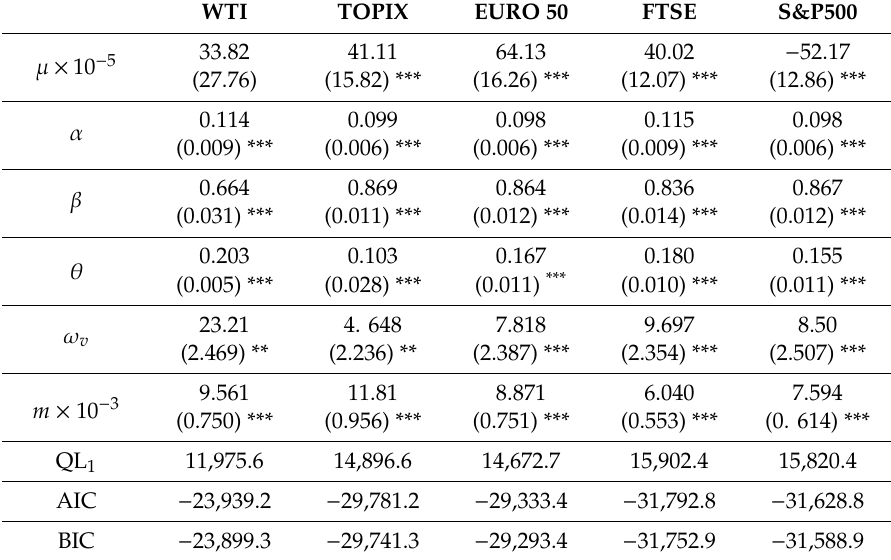
Table 2. Estimations of generalized autoregressive conditional heteroskedasticity–mixed data sampling (GARCH–MIDAS) coe ffi cients for returns on oil and stock market prices. WTI